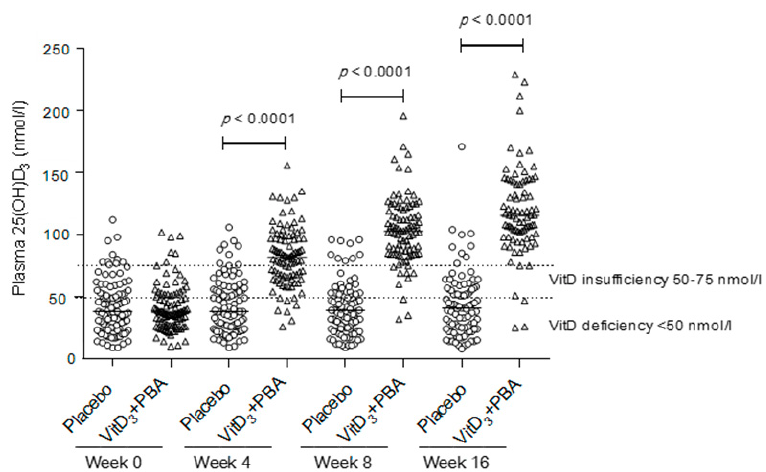
Figure 4. Vitamin D status. Plasma levels of 25(OH)D 3 were assessed at baseline and at weeks 4, 8, and 16 after initiation of vitD 3 + PBA supplementation. Placebo (circles) compared with the vitD 3 + PBA group (triangles) is shown in a scatter dot plot. The solid line indicates the median, and the dashed lines mark the different thresholds for vitD 3 deficiency and insufficiency